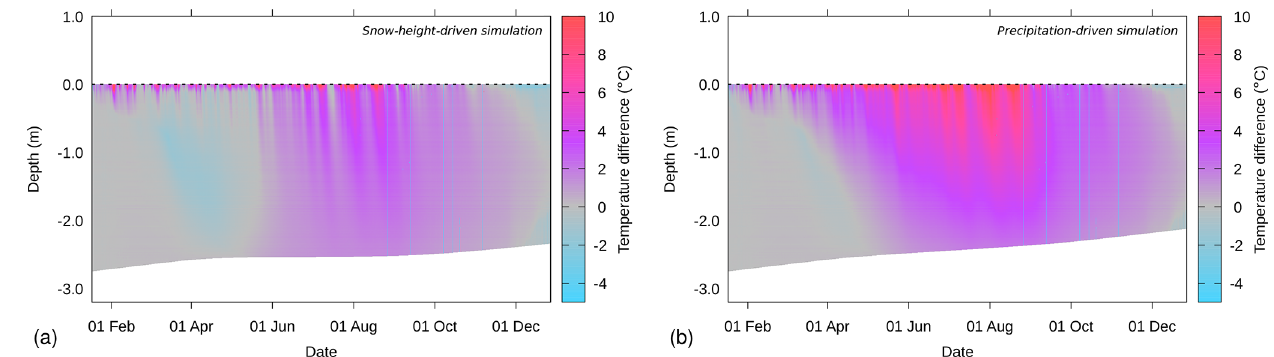
Figure 6. Difference between simulated and measured snow and ice temperatures for snow buoy 2016S31/IMB 2016T41, for (a) simulations driven by in situ measured snow depth and (b) simulations driven by ERA5 precipitation. The depth on the y axis is defined relative to the snow–ice interface, as determined upon